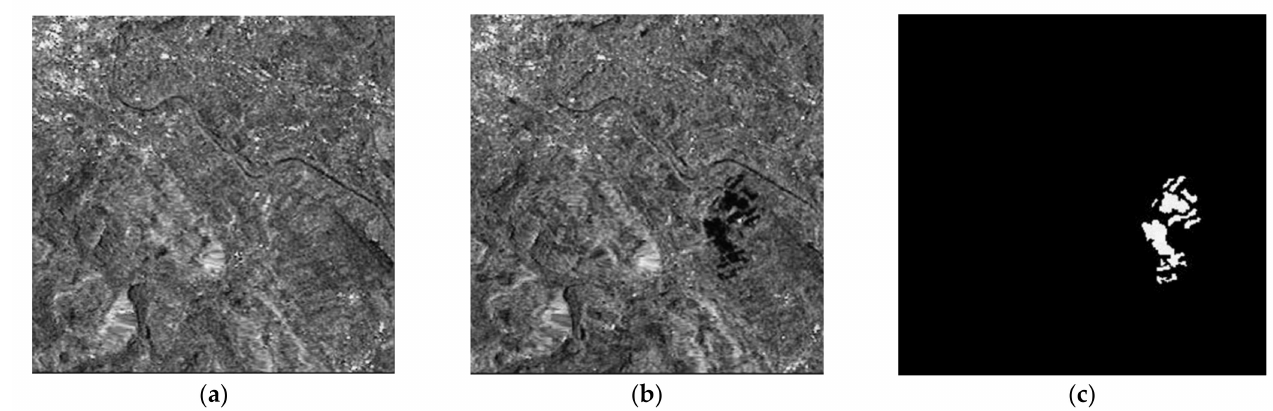
Figure 4. Multi-temporal SAR images of the city of Bern. ( a ) SAR image acquired in April 1999 before the flooding. ( b ) SAR image acquired in May 1999 after flooding. ( c ) The reference map, called ground truth.